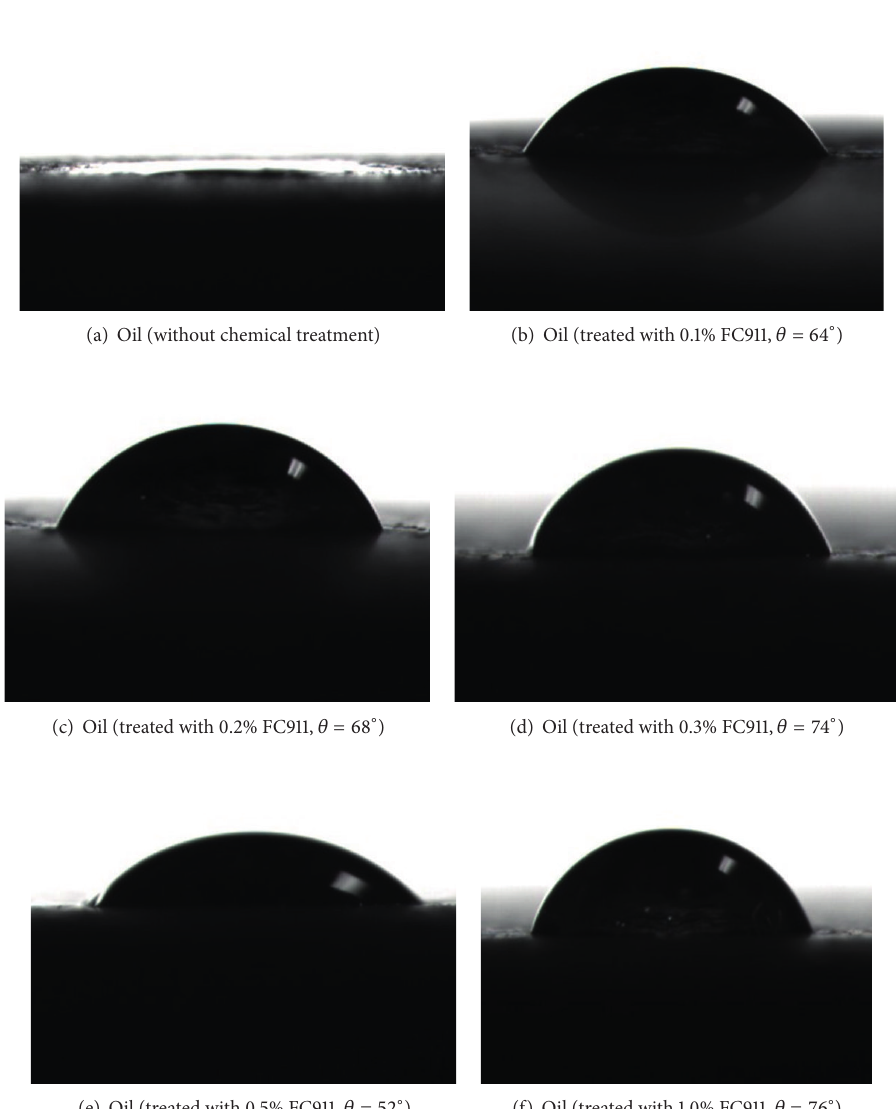
Figure 2: Oil droplets on the surface of the sandstone cores before and after treatment with